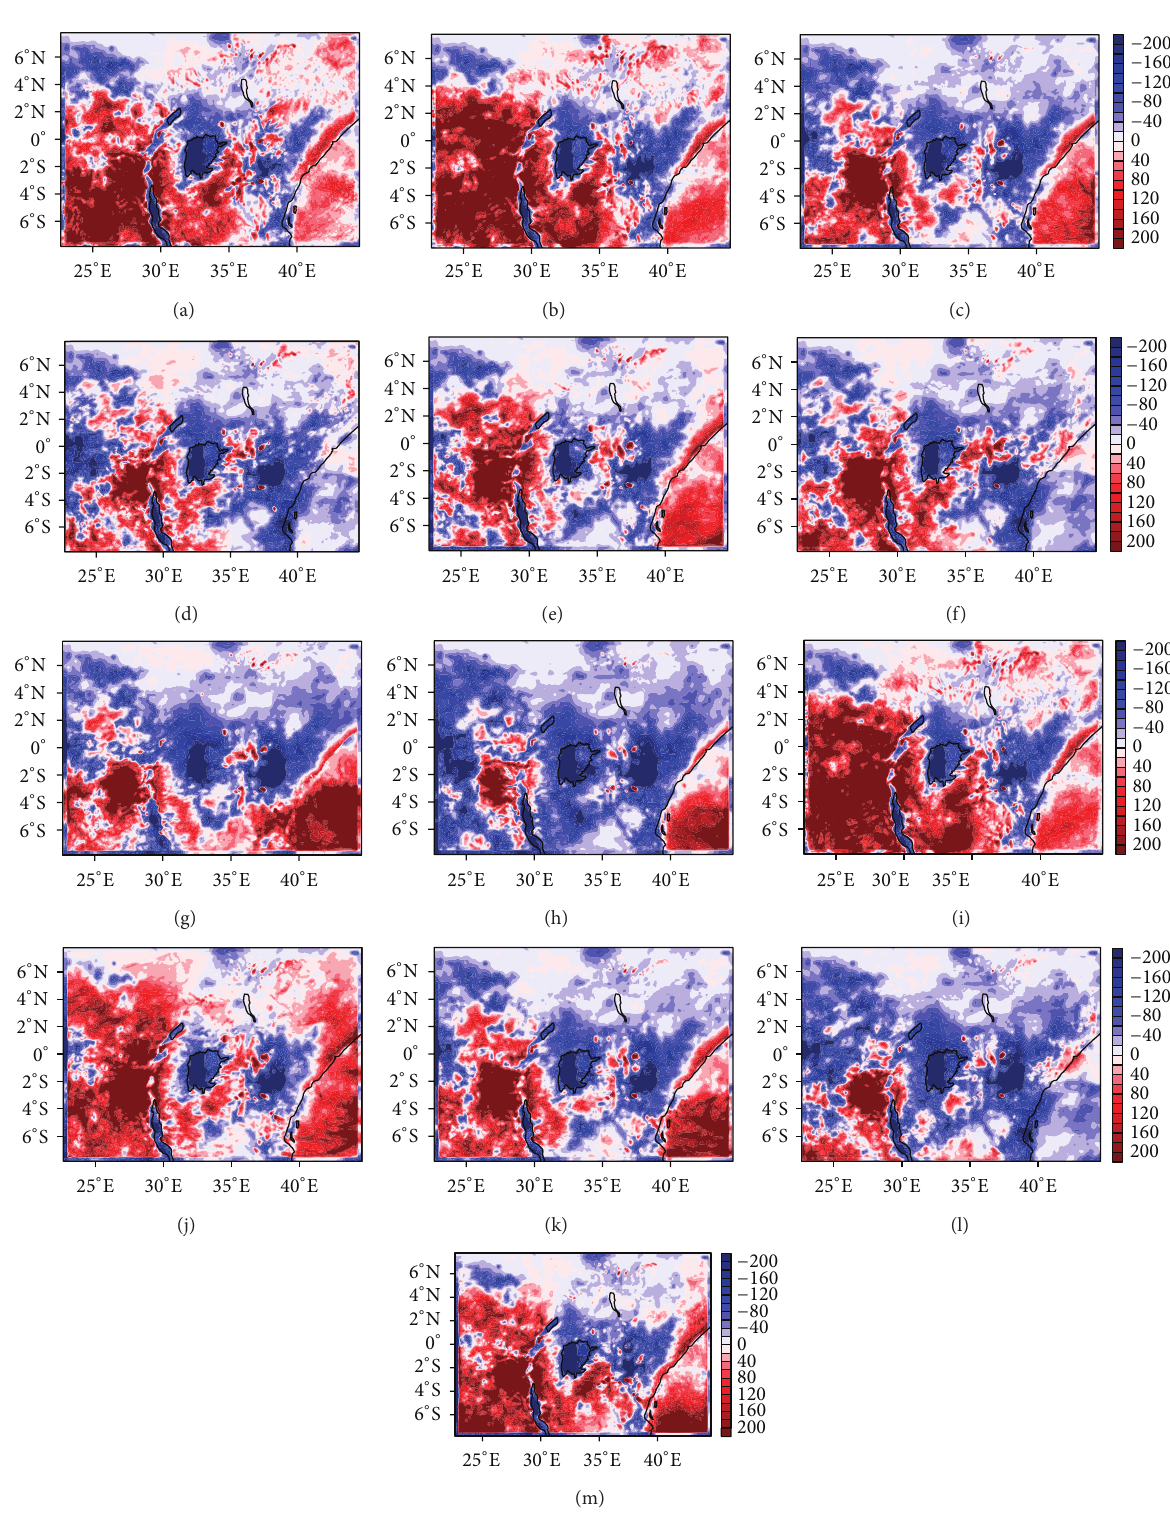
Figure 5: The difference between the WRF output and the TRMM data for each combination in domain two. Blue shows where the model underestimates and red where it